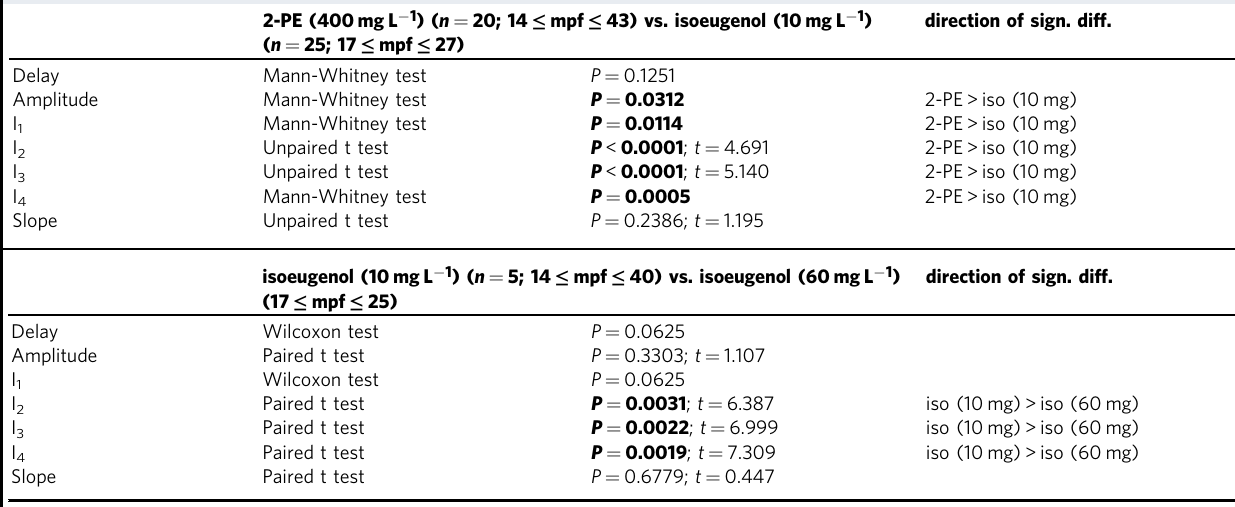
Table 2 Effects of isoeugenol anesthesia on the acoustically in the Mauthner neuron-induced postsynaptic